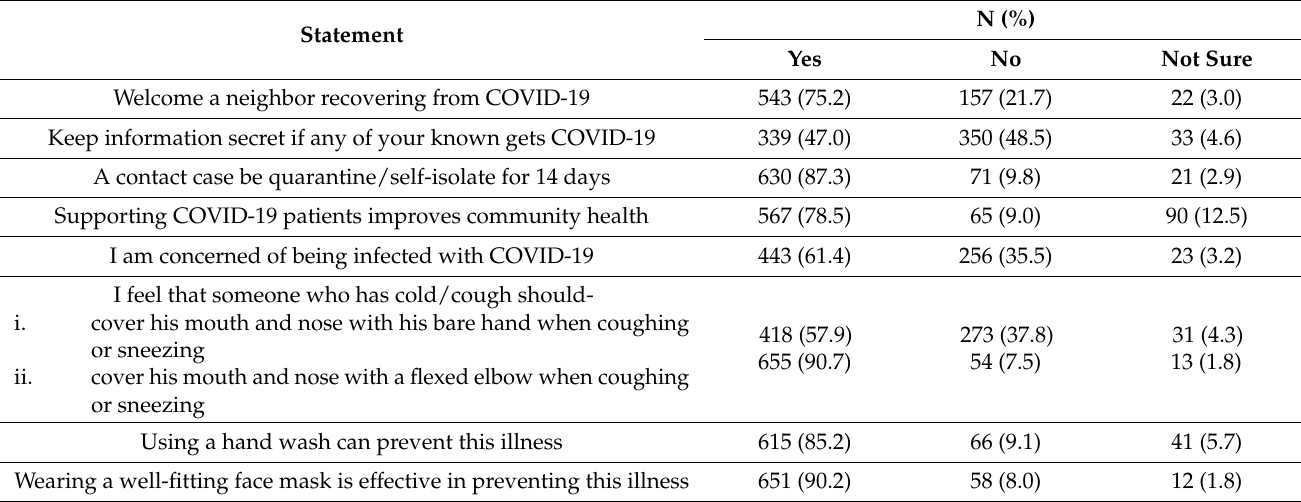
Table 4. Responses to attitudinal statements regarding